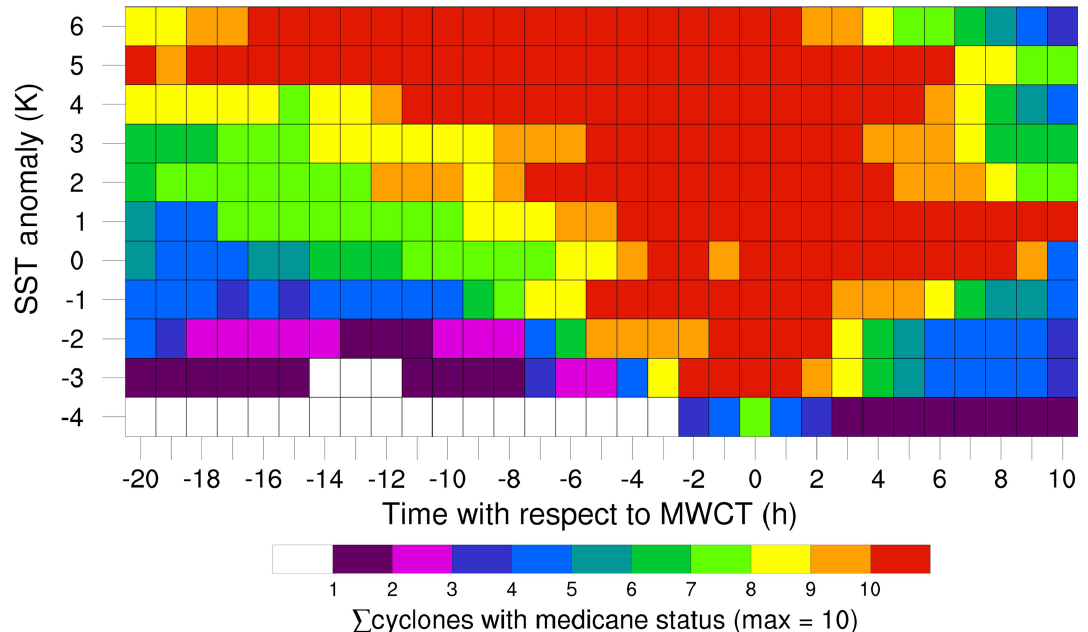
Figure A1. Number of medicanes in each composite (one composite per SST state, y axis) that have medicane status at a given time relative to MWCT. Note that each composite contains 10 members, except for the − 4K anomaly SST composite, which contains only 7 members as only 7 members underwent